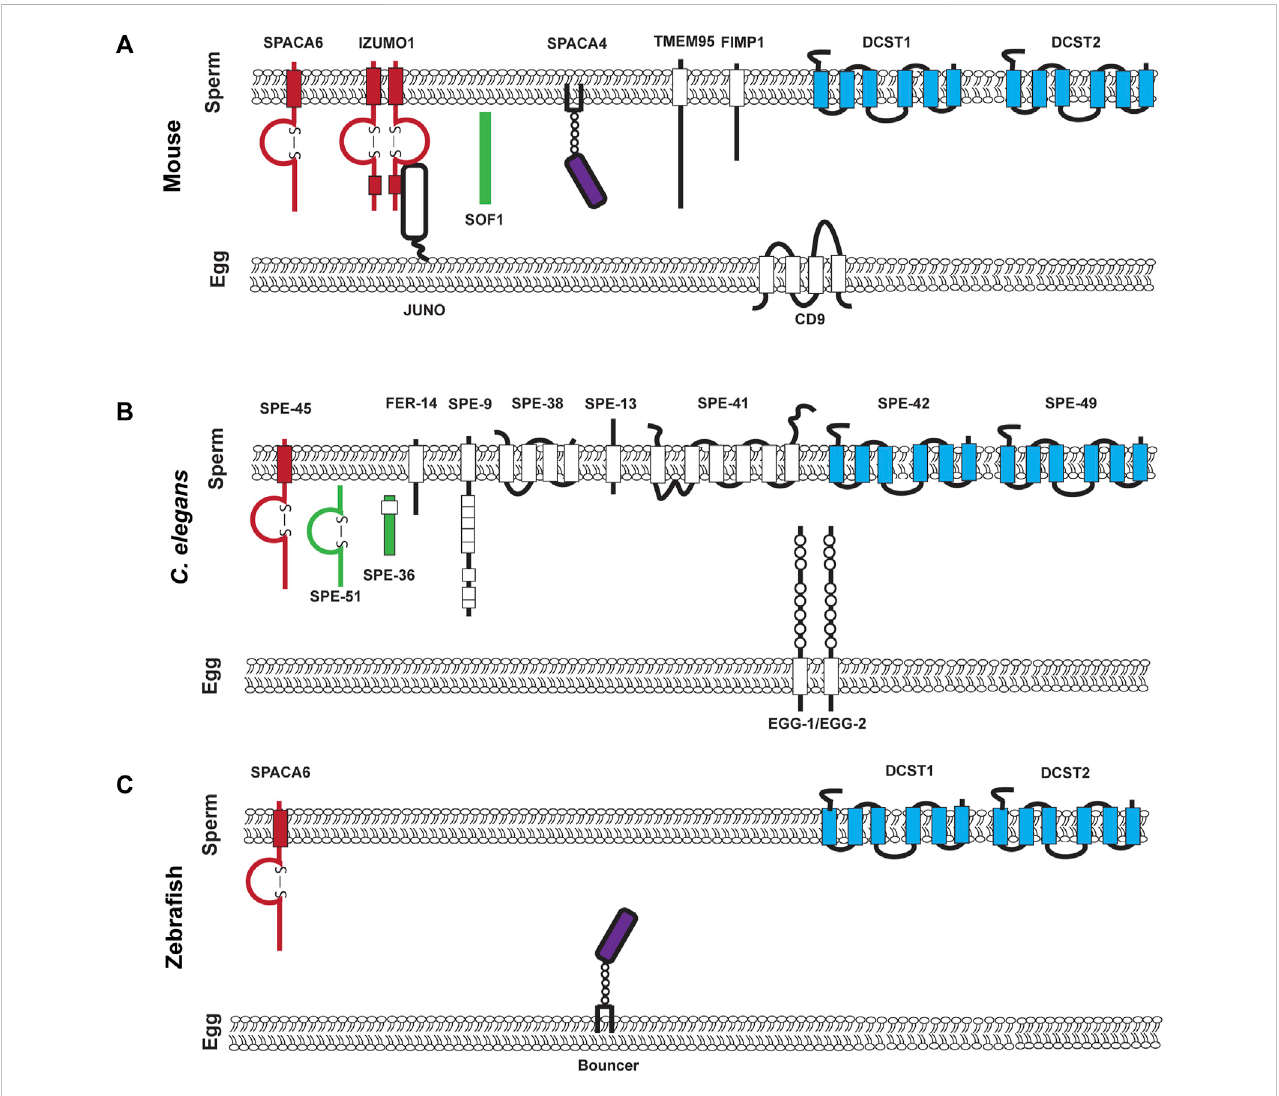
FIGURE 1 Known components of the mouse, C. elegans , and Zebra fi sh fertilization synapse. (A) . Mouse fertilization synapse, (B) . C. elegans fertilization synapse, and (C) . Zebra fi sh fertilization synapse. For (A – C) each of the molecules that are denoted have been experimentally validated though loss of function mutations. Proteins on the left of each synapse in red contain an immunoglobulin domain, proteins in green are secreted, proteins in purple are in the uPAR/ Ly6 family and on the right in blue are conserved DCSTAMP